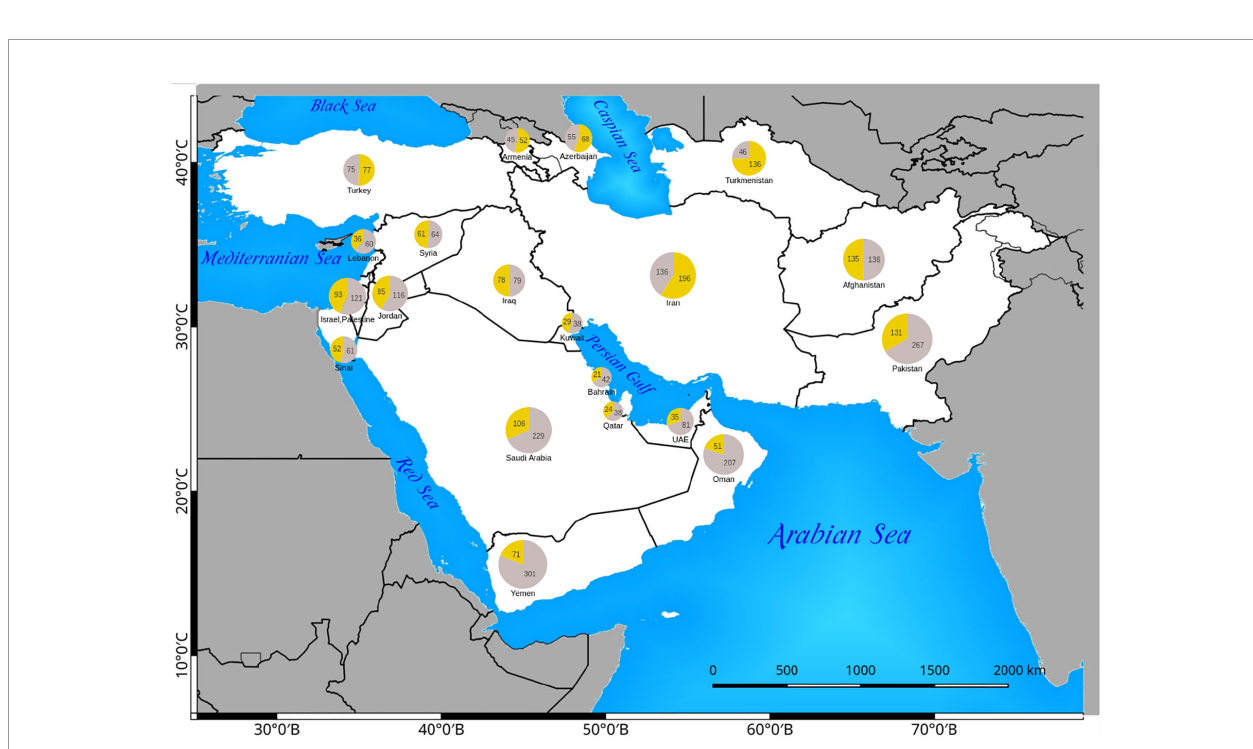
FIGURE 4 | Distribution of native Eudicot (yellow) and Monocot (gray) species in Southwest (SW) Asian countries. The absolute number of C 4 Monocots and Eudicots are indicated in the respective pie